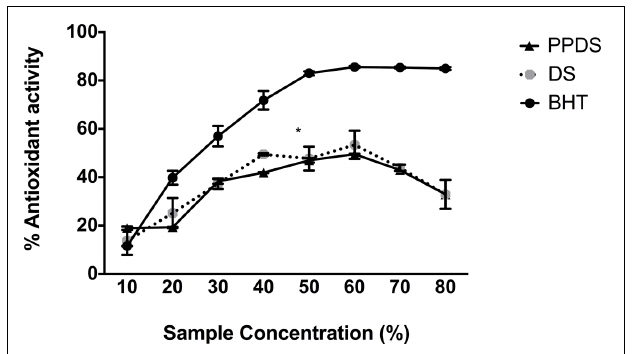
FIGURE 1 | Comparison of the antioxidant potential of date syrup (DS) (round gray scale dot) and extracted DS polyphenol (PPDS) (black triangle) against the commercially available antioxidant butylated hydroxytuolene (BHT) (black dot). Results are expressed as mean ± SD of three independent experiments and significant difference between DS treatments and BHT is indicated as ∗ p < 0.05.